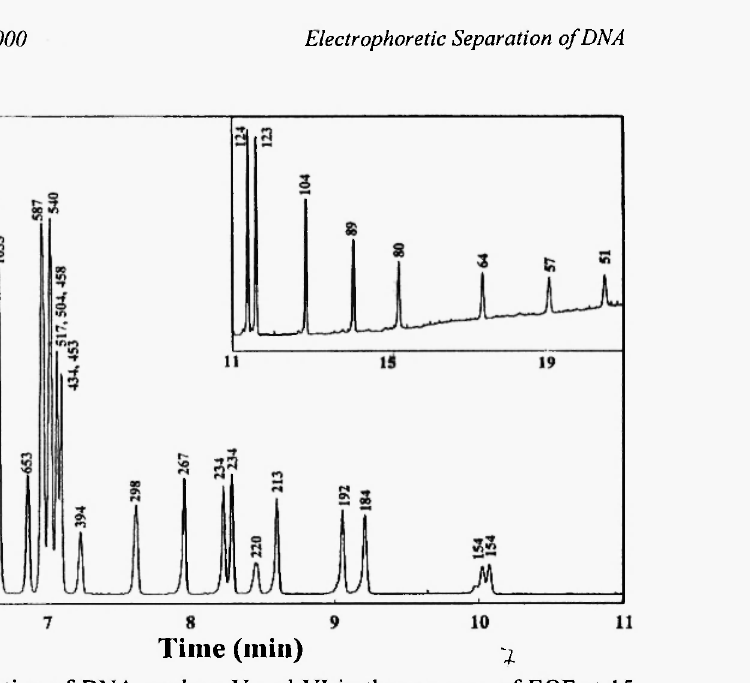
Fig. 7: Separation of DNA markers V and VI in the presence of EOF at 15 KV, using a 2% PEO solution containing 20 μg/mL EB. Buffer vials contain the 2% PEO and 20 μg/mL EB solution. Capillary: 40 cm in total length and 30 cm in effective length; filled with a 1 X TBE solution containing 20 μg/mL EB. (Adapted with permission from Ref.